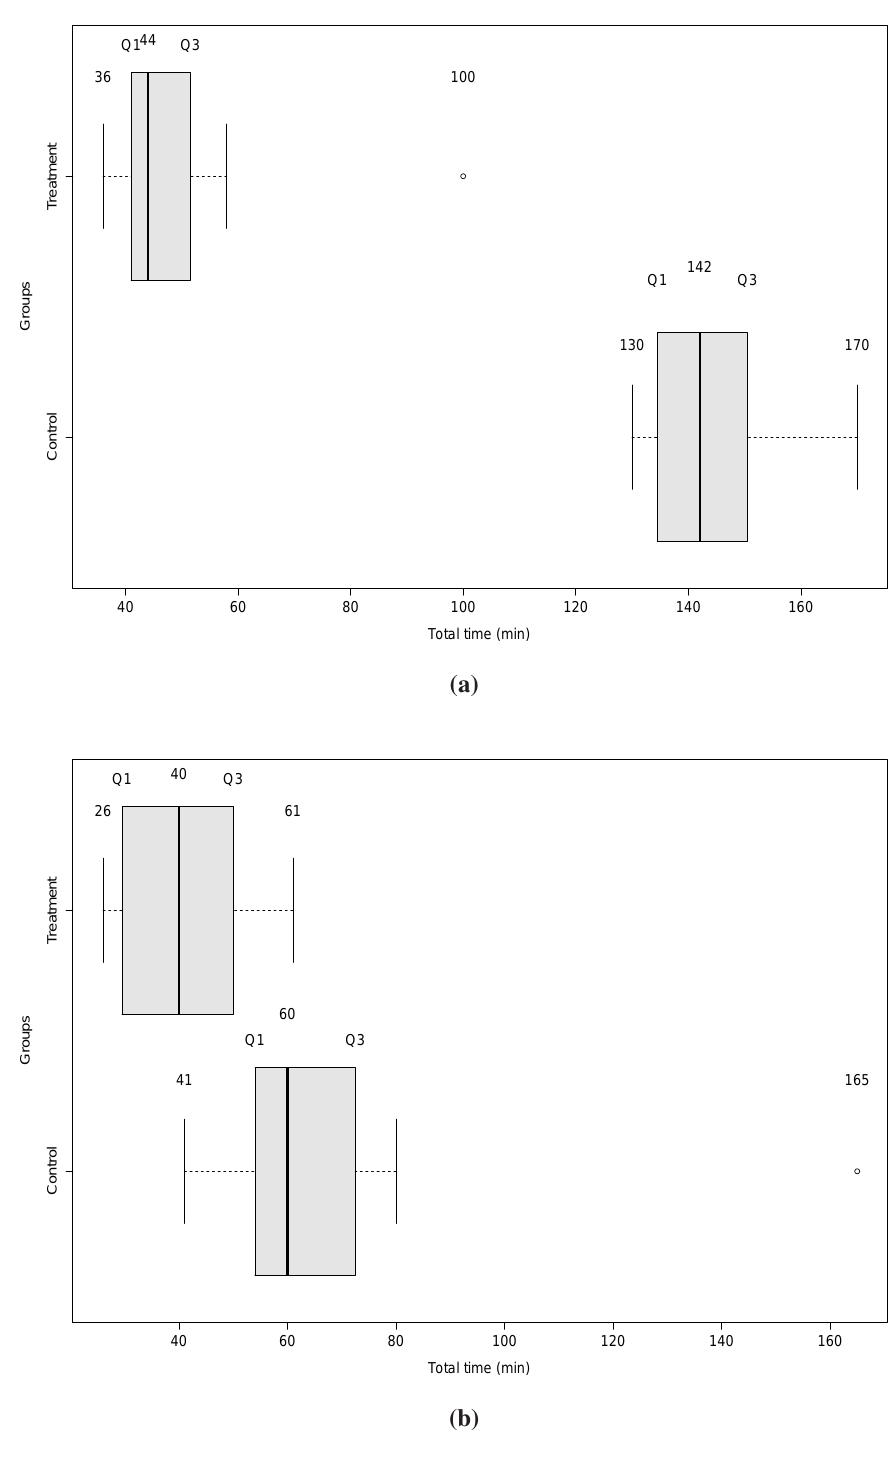
Figure 23. Boxplots of the Time Collected for the Control and Treatment Group. ( a ) First Problem—Clinical Context I.; ( b ) Second Problem—Clinical Context